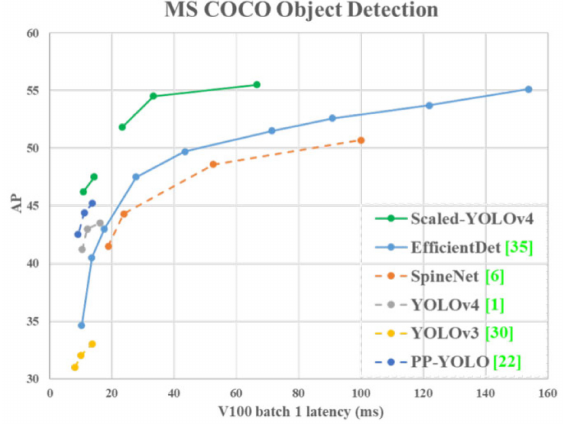
Figure 3. Negative samples in the HAIDA trash dataset. ( a ) Negative samples in the Badouzi fishing port at heights of 7 and 30 m. ( b ) Negative samples in the Badouzi fishing port at heights of 15 and 10 m.